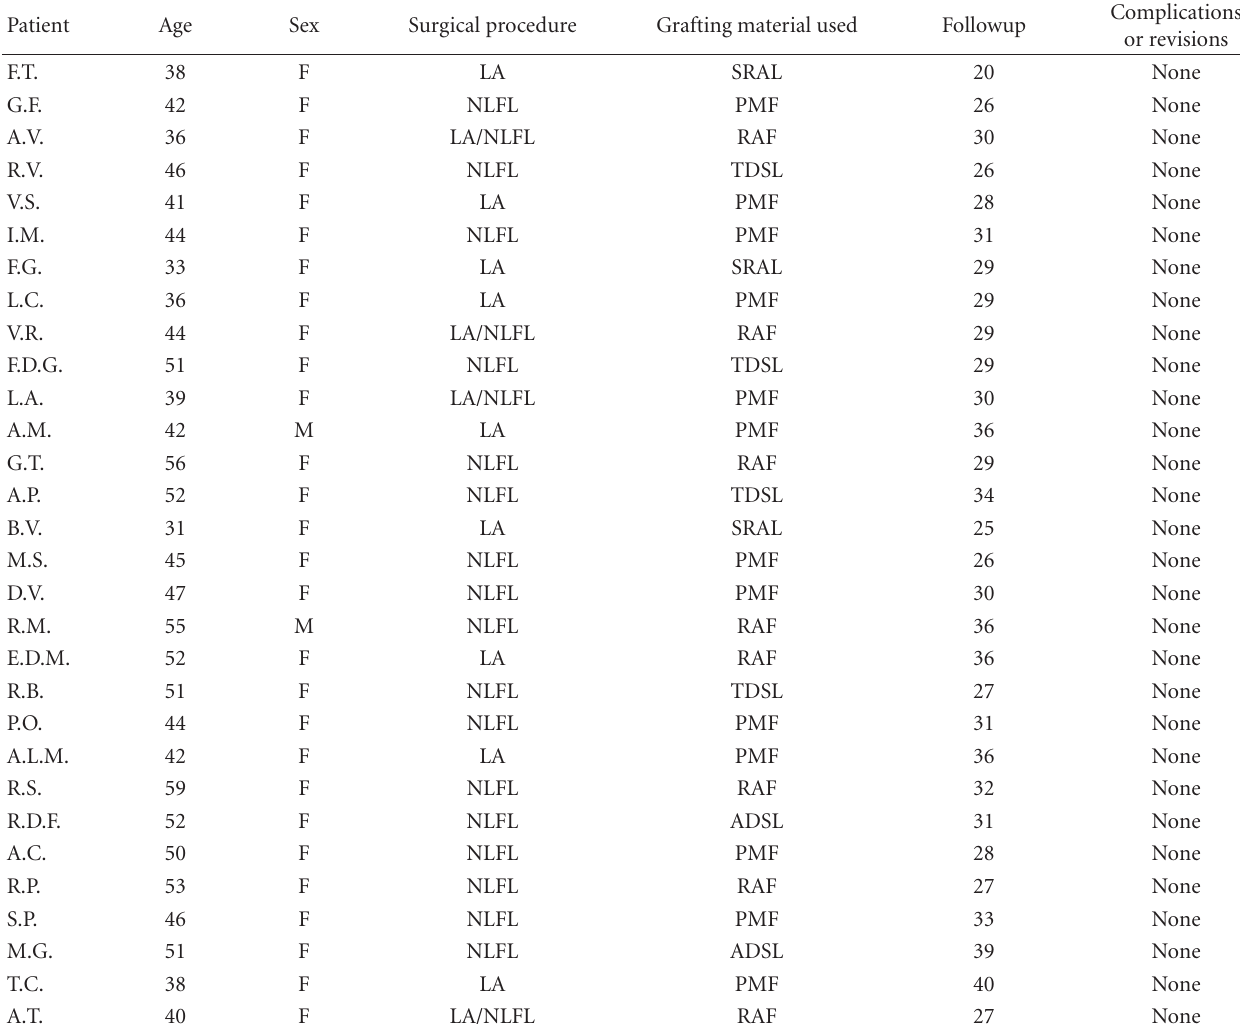
Table 1: Synoptical table concerning a case series of interventions of tissues